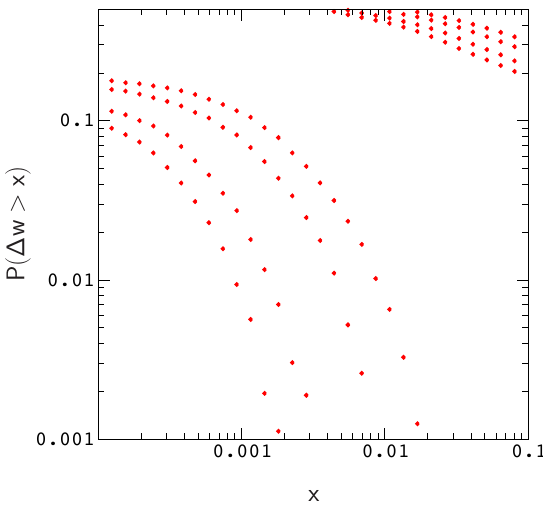
Figure 1. Distribution of beneficial fitness effects, P ( ∆ w > x ) . The distribution of deleterious fitness effects, P ( − ∆ w > x ) , is partially included in the upper right corner of the figure for reference. The plots are generated by randomly mutating evolved sequences sampled from simulations with N = 100, 200, 500, and 1000 (the width of a plot increases with decreasing N ). If the data for ∆ w in each plot is rescaled by the appropriate factor of N , the distributions P ( N ∆ w > x ) roughly collapse to a single curve. For N = 1000, about 47 percent of the mutations are strongly deleterious ( N ∆ w < − 5), about 28 percent are nearly neutral ( − 1 < N ∆ w < 1), and about 0.7 percent are beneficial ( N ∆ w > 1), consistent with results obtained by Tamuri et al. [39] for mammalian mitochondrial proteins (Tamuri et al. use logarithmic fitness differences in their work, however, this distinction can be neglected when ln ( 1 + x ) (cid:39) x